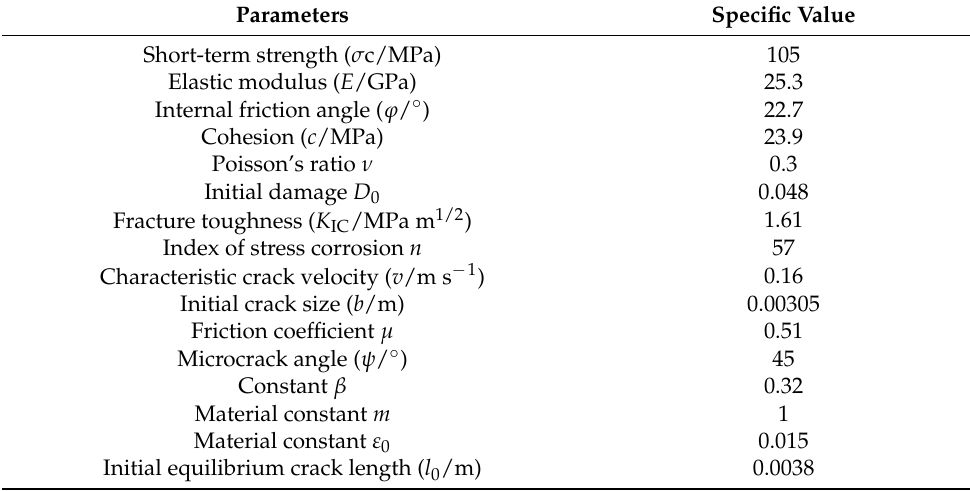
Table 1. Mechanical parameters for Jinping marble on the macro- and